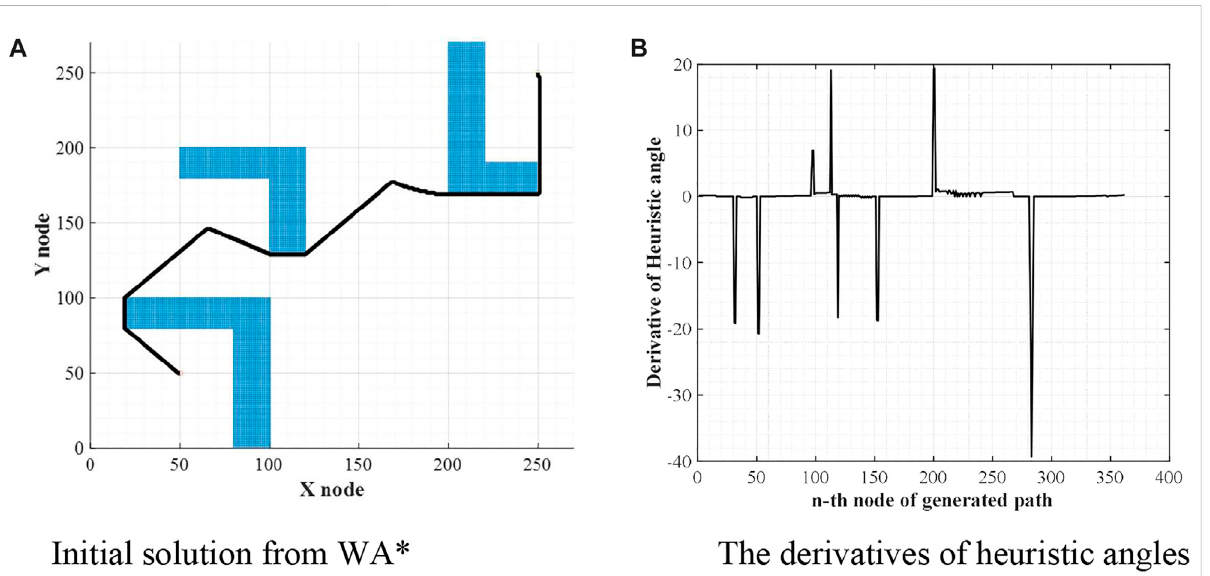
FIGURE 2 Initial solution and their derivatives of heuristic angles. (A) Initial solution from WA*. (B) The derivatives of heuristic angles.